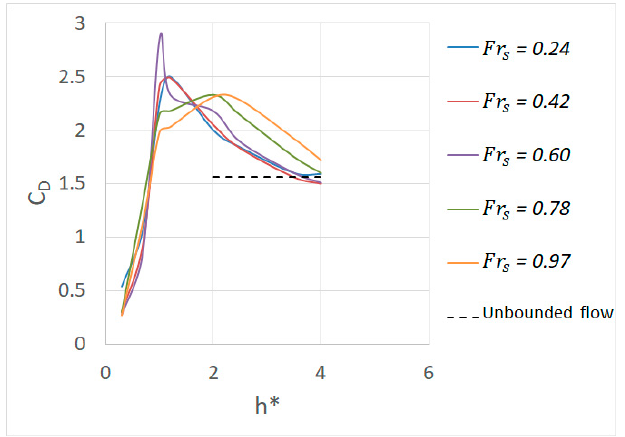
Figure 18. Drag coefficient versus inundation ratio for different upstream velocities. Geosciences 2018 , 8 , x FOR PEER REVIEW